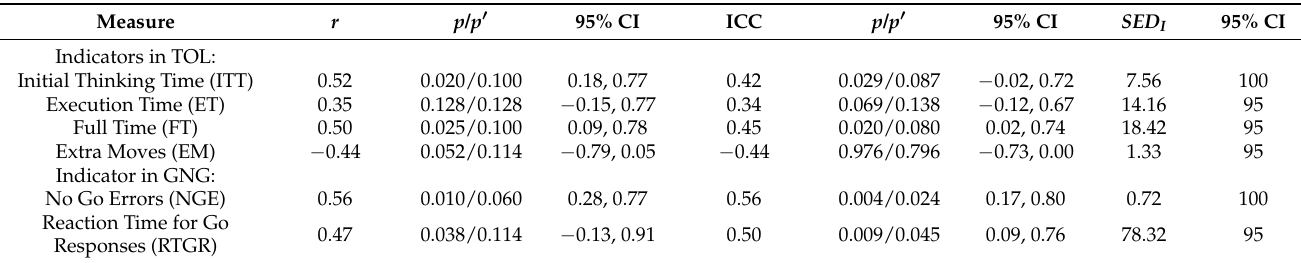
Table 5. Person’s r , interclass correlation (ICC), and reliable change indices (RCI) for all indicators on Tower of London (TOL) and Go/No Go (GNG) task.